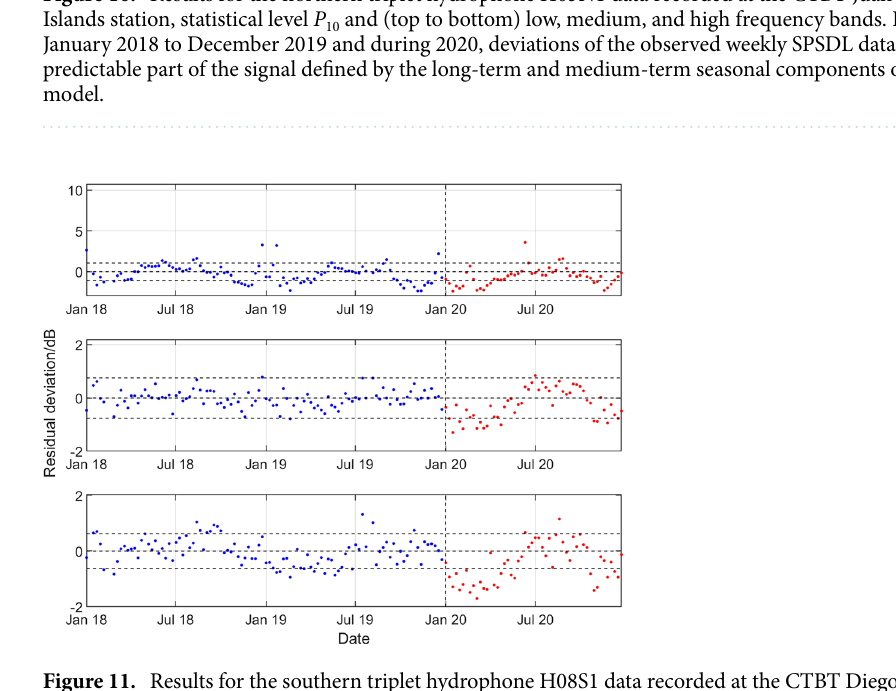
Figure 11. Results for the southern triplet hydrophone H08S1 data recorded at the CTBT Diego Garcia Island station, statistical level P 10 and (top to bottom) low, medium, and high frequency bands. For the period January 2018 to December 2019 and during 2020, deviations of the observed weekly SPSDL data from the predictable part of the signal defined by the long-term and medium-term seasonal components of the GP